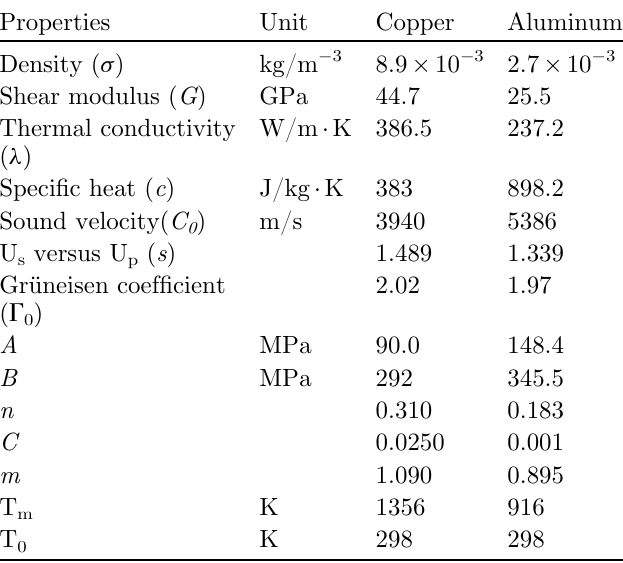
Table 1. Material model for the numerical analysis.